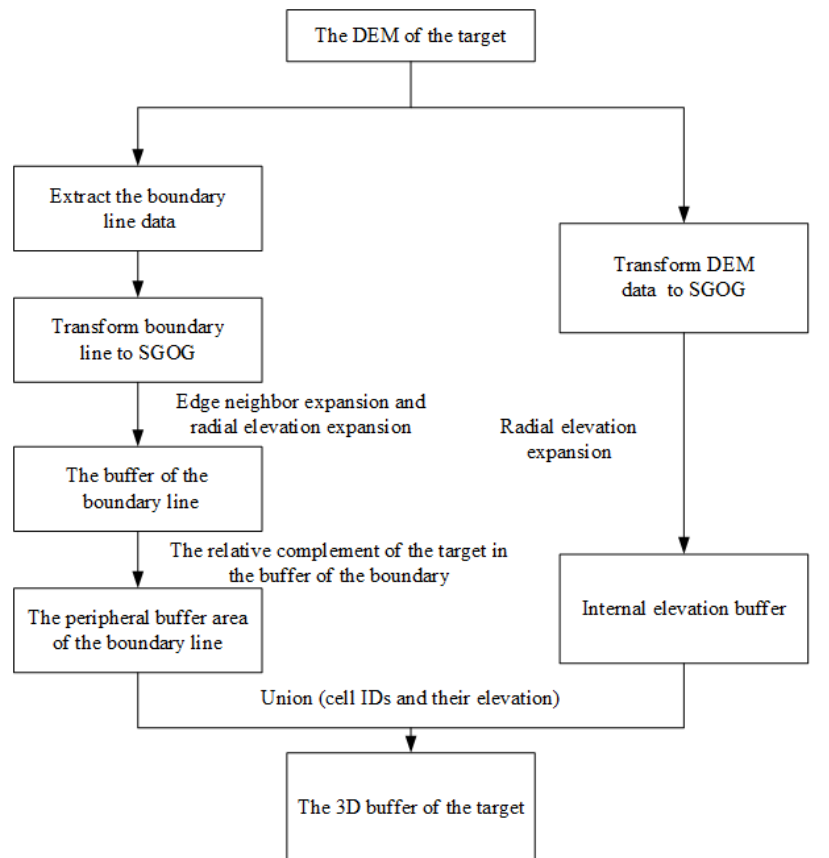
Figure 7. Flow chart of volume object 3D buffer generation.